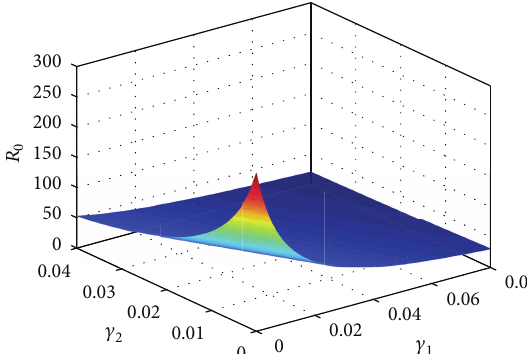
Figure 5: An illustration of the impact of 𝛾 1 and 𝛾 2 on 𝑅 0 .